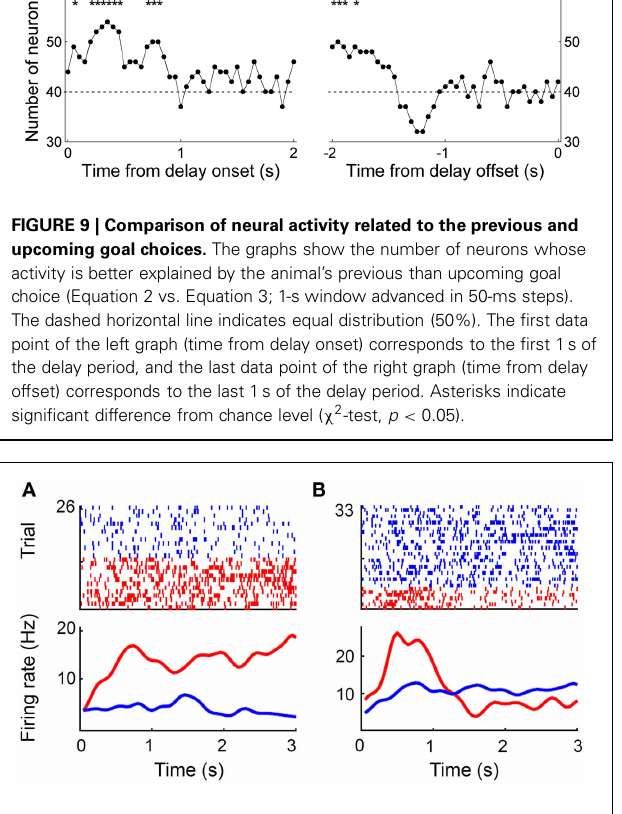
FIGURE 10 | Reward-related neural activity. (A) A unit that changed its firing rate during the reward period according to goal location. Trials were divided according to the chosen goal (red, left; blue, right). Only correct trials are shown. (B) A unit that changed its firing rate according to trial outcome. Trials were divided according to trial outcome (red, error; blue, correct). A spike raster plot (top) and a spike density function ( σ = 100ms) are shown for each example. Time 0 indicates the onset of the reward